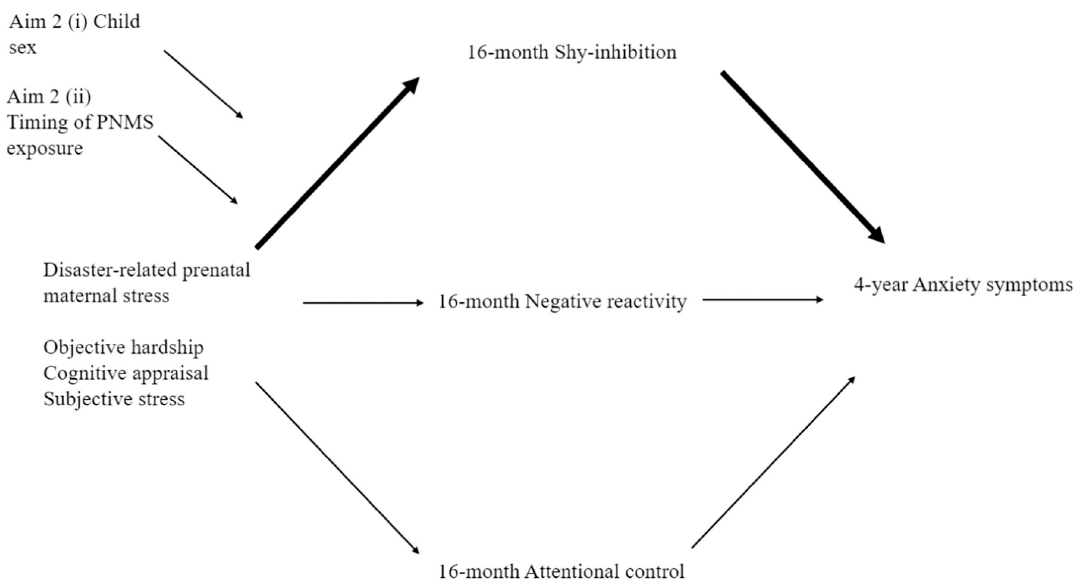
Figure 1. Conceptual diagram outlining the full, moderated mediation model of the indirect effects of disaster-related prenatal maternal stress (PNMS) on child anxiety symptoms as moderated by (a) child sex or (b) timing of exposure.